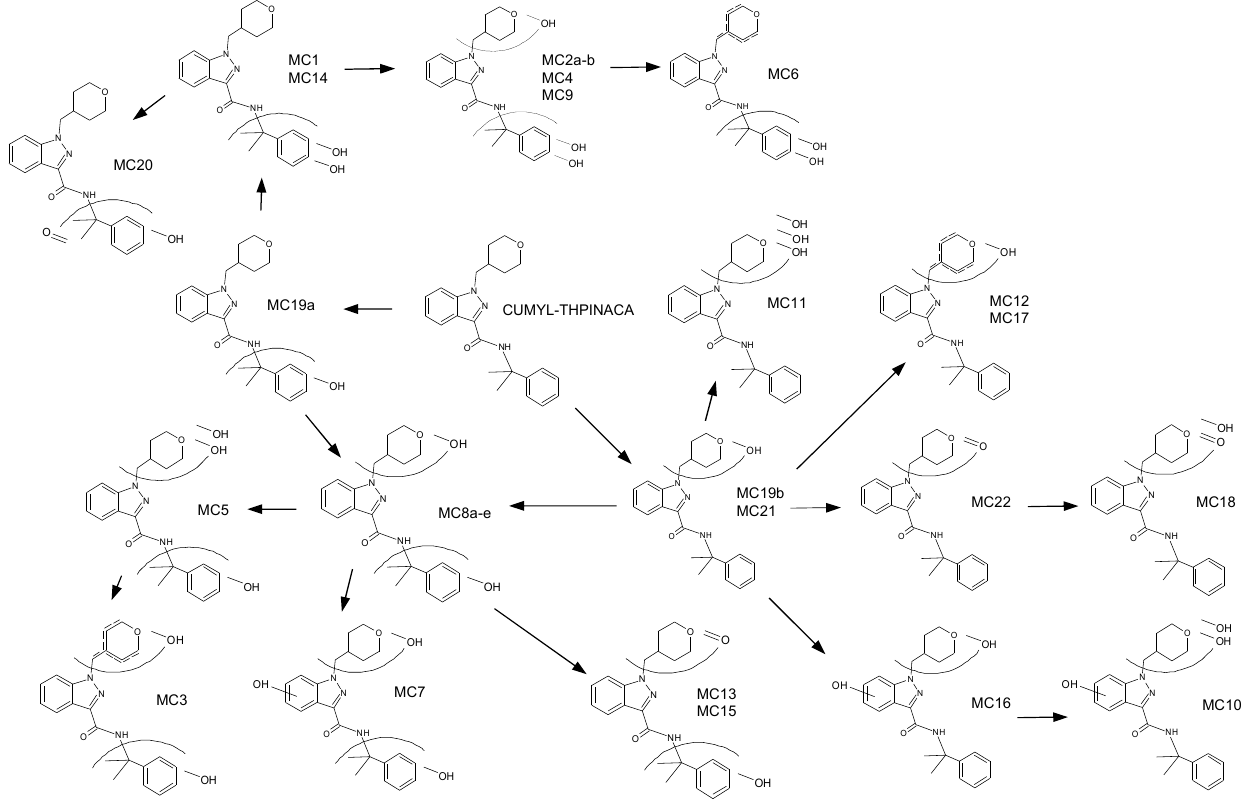
Figure 2. Proposed metabolic pathway for CUMYL-THPINACA .